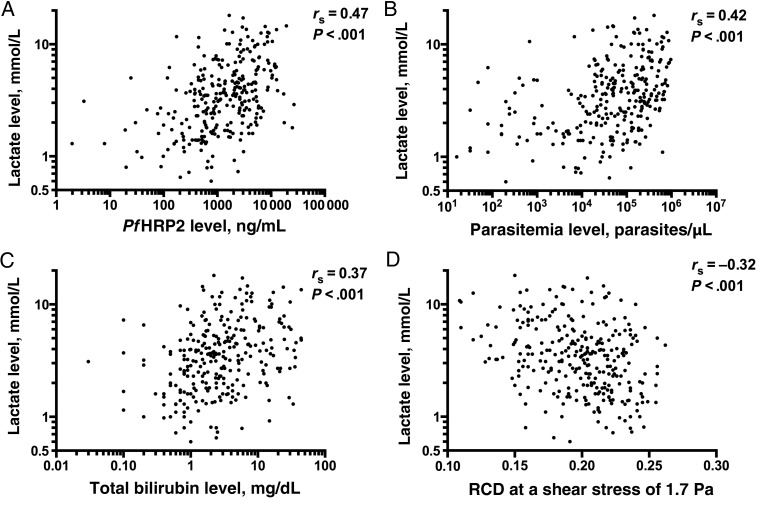
Univariate correlations of plasma lactate concentration with Plasmodium falciparum histidine-rich protein 2 (PfHRP2) level (A), parasitemia level (B), total bilirubin level (C), and red blood cell deformability (RCD) at a shear stress of 1.7 Pa (D).